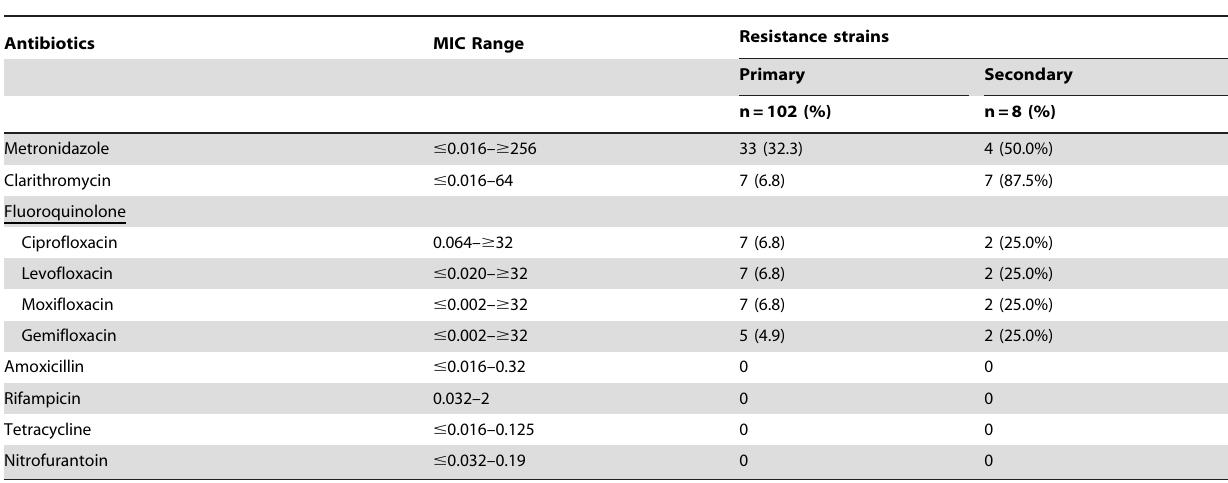
Table 2. Primary and secondary antibiotic resistance